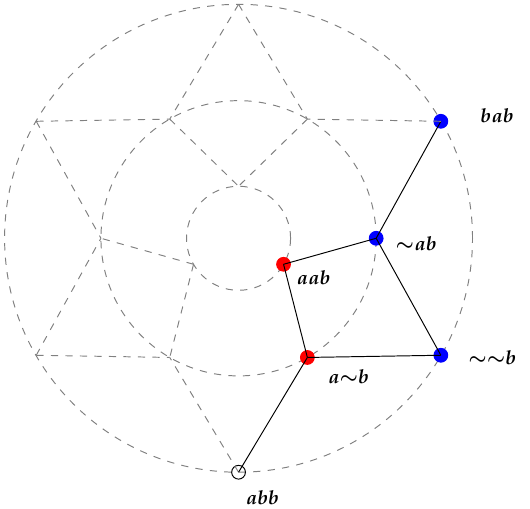
Figure 4 Figure 4. The subcase φ ( a b ) = a and φ ( ∼